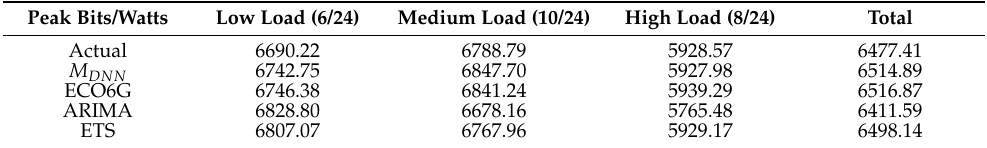
Table 3. Peak bits per watts calculation.